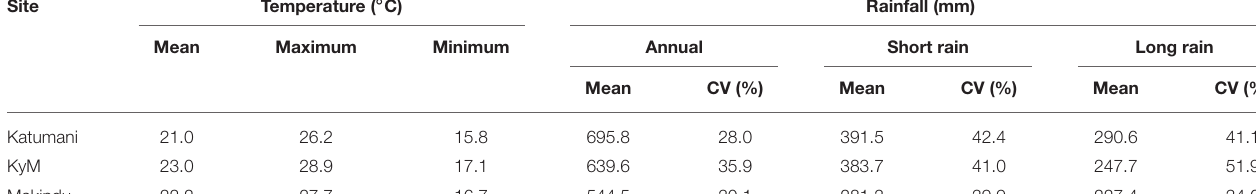
TABLE 5 | Rainfall and the respective coefficient of variation (CV) for three study sites in Eastern Kenya, including Katumani, Kampi ya Mawe (KyM), and Makindu calculated from different datasets as indicated in Table 1. Site